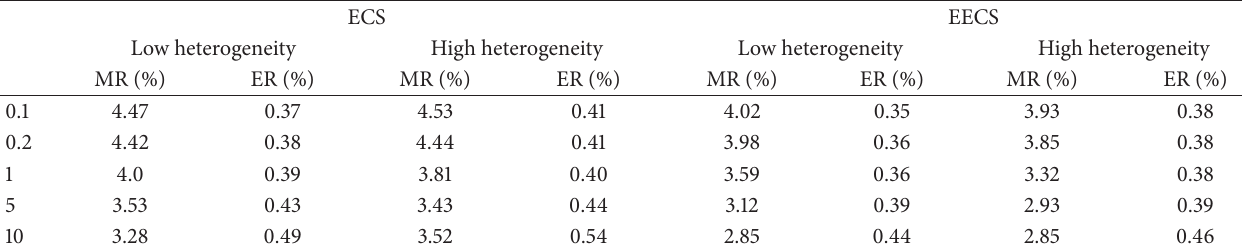
Table 9: Comparative results of Figure 5: LIGO, 77 nodes (different heterogeneities of processors). ECS